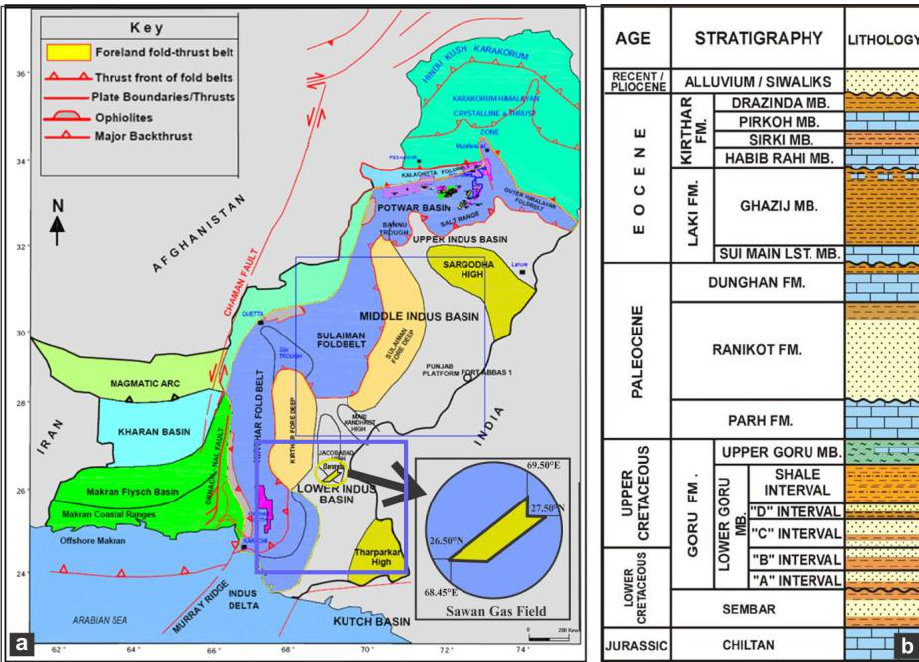
Figure 1. ( a ) Regional geological map showing the structural settings, tectonics, and local multiple sedimentary basins of Pakistan. The Sawan gas field is located near Jacobabad-Khairpur Highs towards the junction of the Middle and Lower Indus Basin (highlighted by blue squares); ( b ) generalized stratigraphy of the study area (lower Indus Basin).